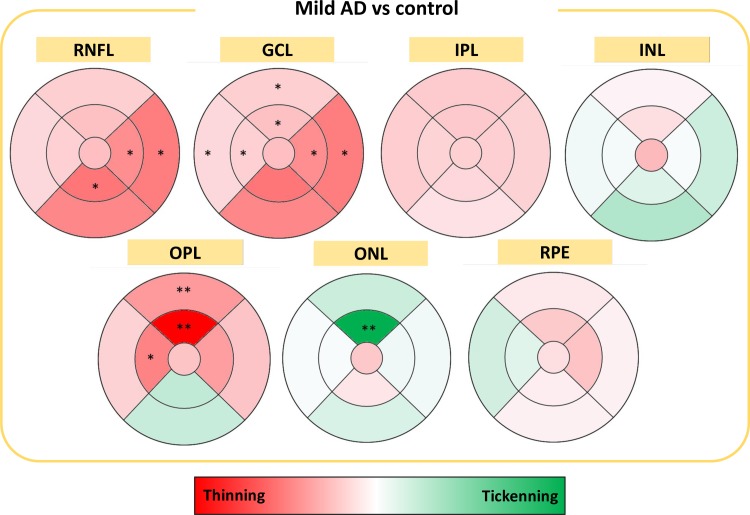
Colorimetric percentage differences of the all retinal layers between mild AD and control group.In red, thickness decrease; in green thickening. *P < 0.05. **P < 0.01. Mann-Whitney U test.